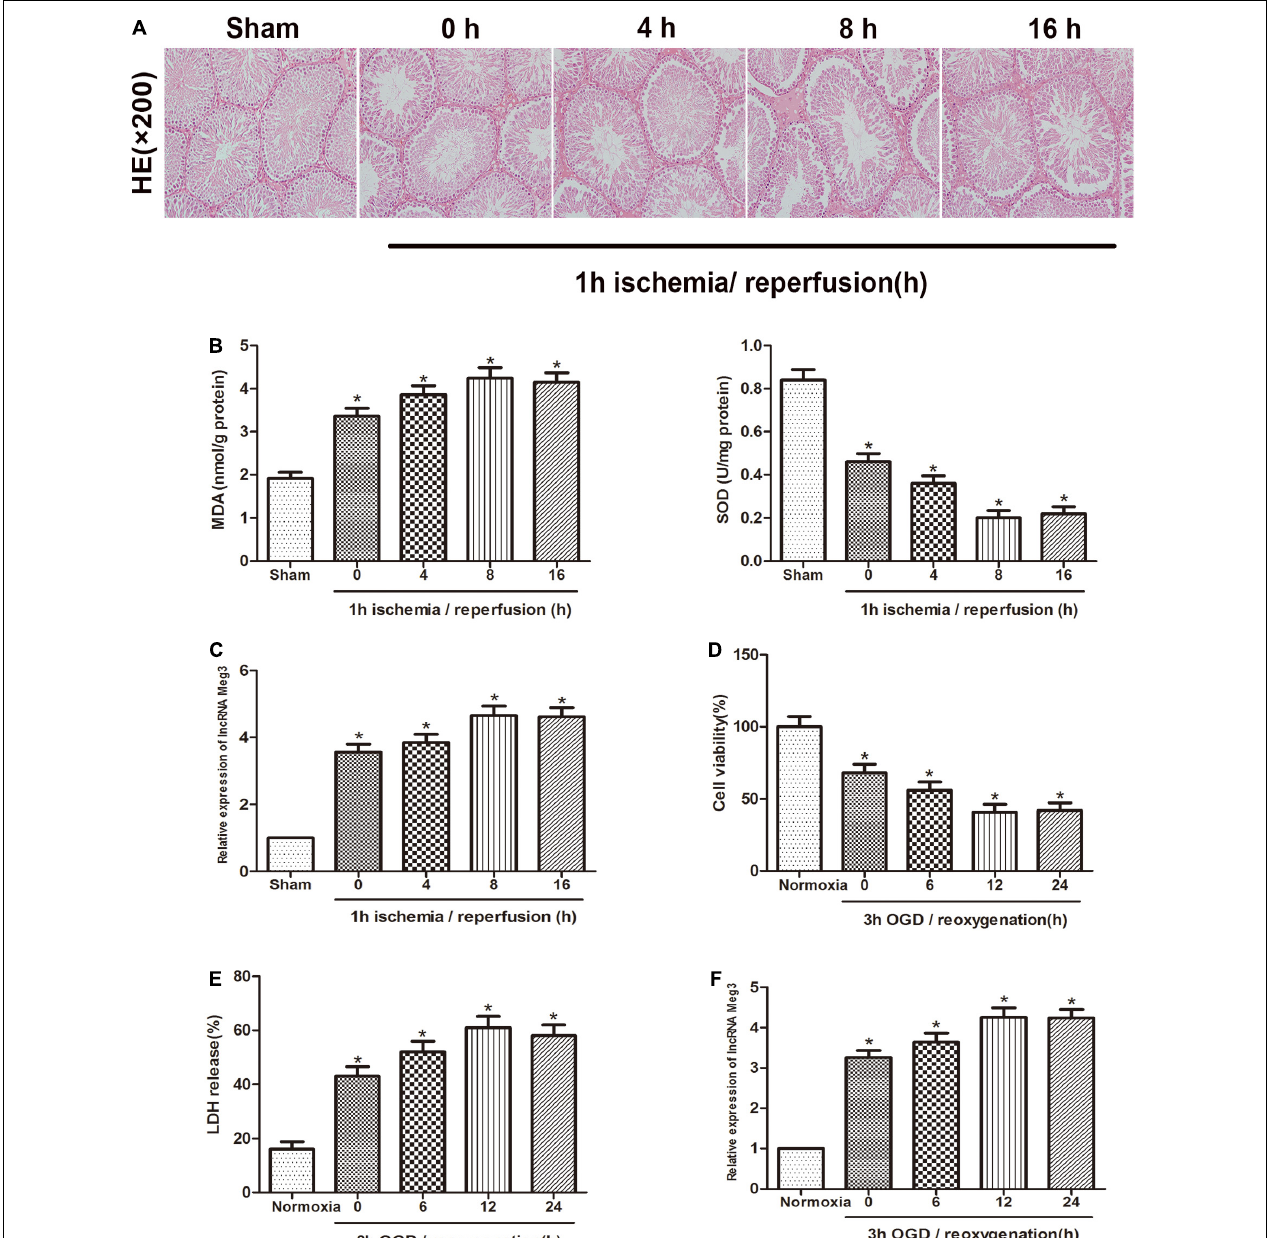
FIGURE 1 | MEG3 is upregulated in testicular I/R and cellular OGD/R. (A) Comparison of testicular H&E staining in the sham-operated group and at different reperfusion times (0, 4, 8, and 16 h) after 1 h of ischemia. (B) Comparison of MDA and SOD levels in the sham-operated group and in animal tissues at different reperfusion times (0, 4, 8, and 16 h) after 1 h of ischemia. (C) Comparison of MEG3 expression levels by qRT-PCR in sham-operated group and animal samples at different reperfusion times (0, 4, 8, and 16 h) after 1 h of ischemia. (D) Comparison of cell viability between normoxic group and GC-1 cells at different